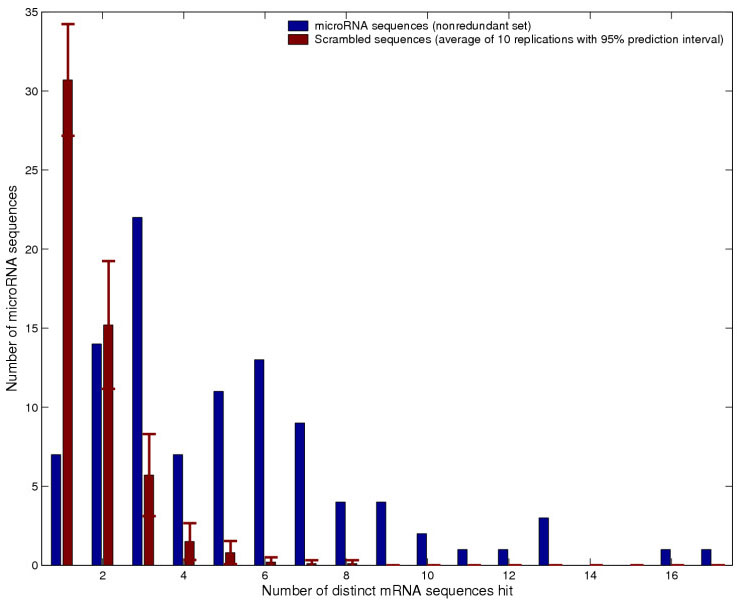
Individual microRNAs hit multiple targets on the candidate list, more often than expected by chance.